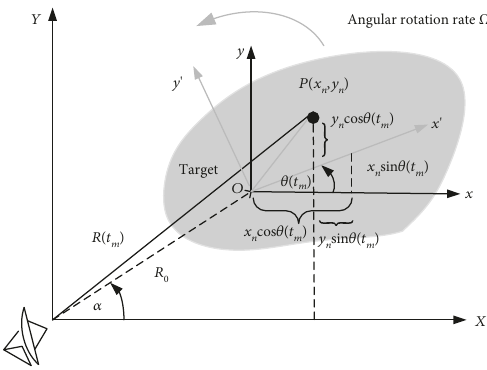
Figure 1: Geometry for a maneuvering target with respect to radar [19]. The Figure reproduced from Hongyin Shi et al. (under the Creative Commons Attribution License/public